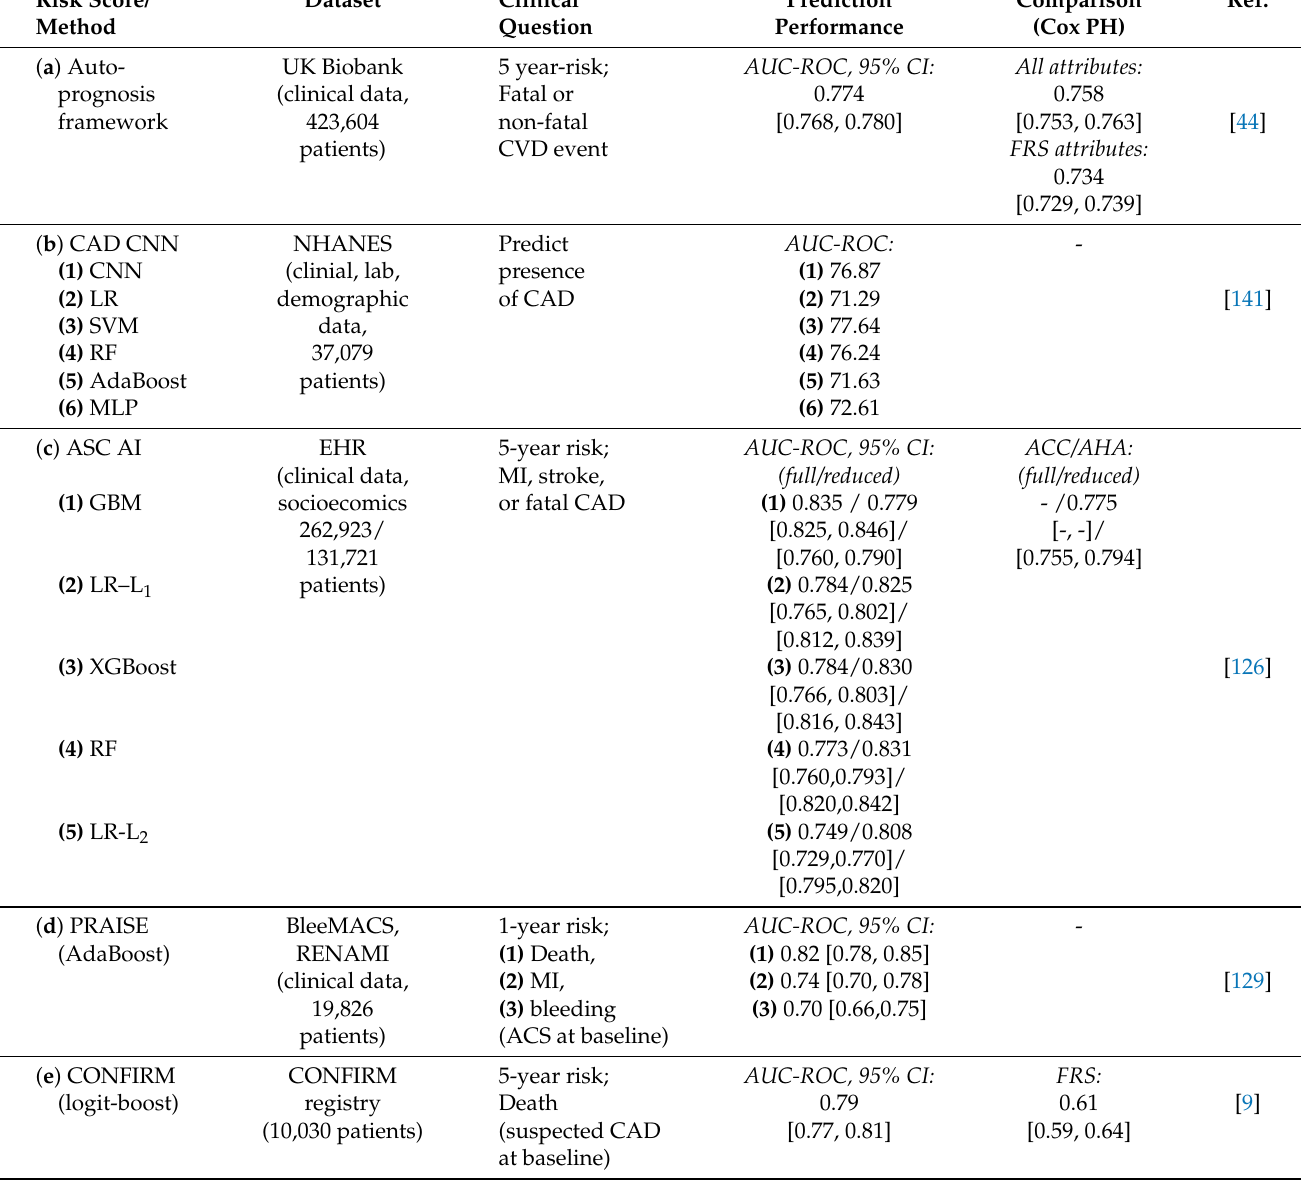
Table 6. Performance of AI models for predicting primary or recurrent events compared to traditional survival